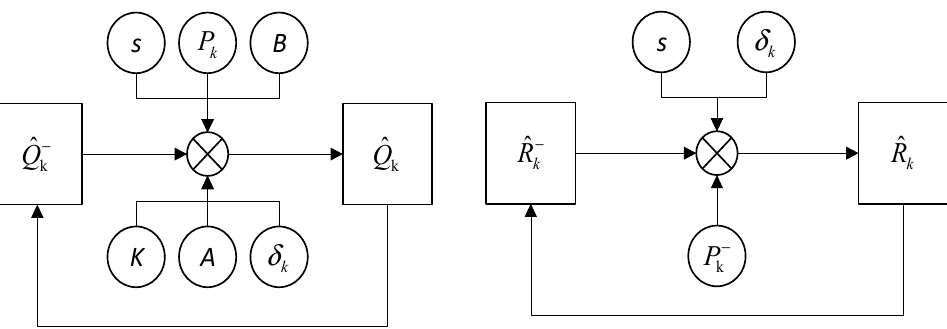
Figure 8. Principle of the adaptive Kalman filter algorithm.